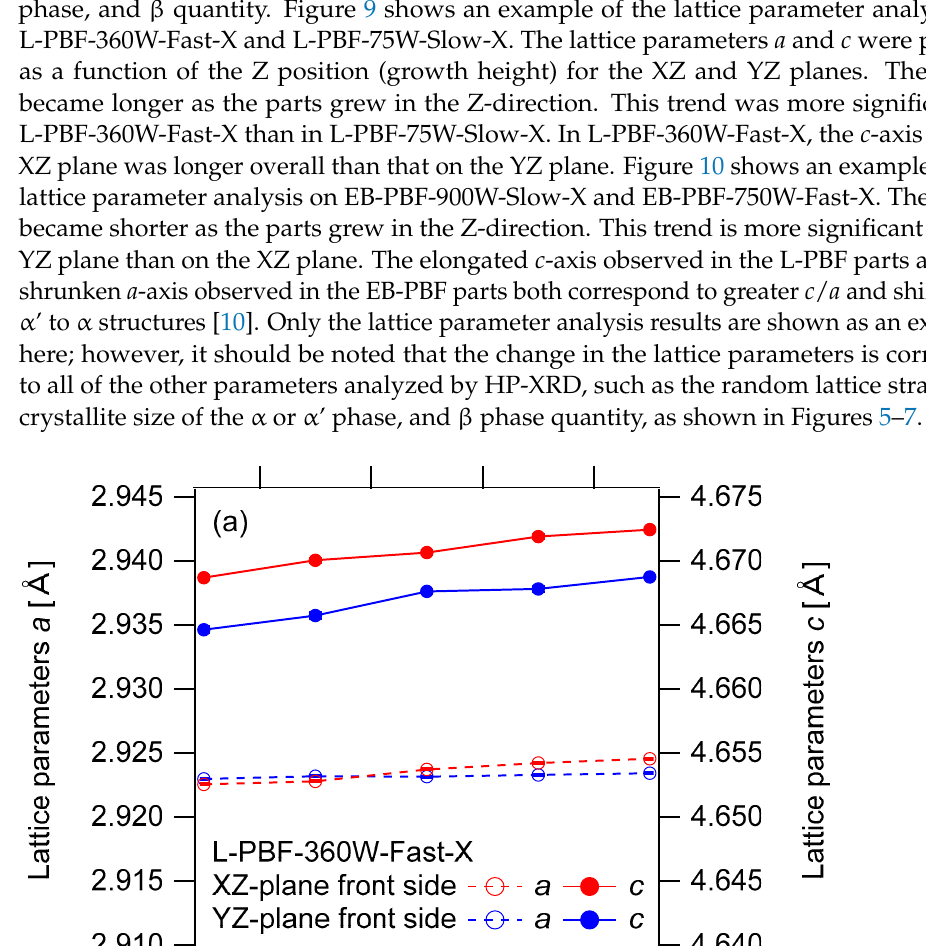
Figure 8. SEM images of the representative microstructures: ( left ) L-PBF-360W-Fast-X; ( right ) EB-PBF-900W-Slow-X.